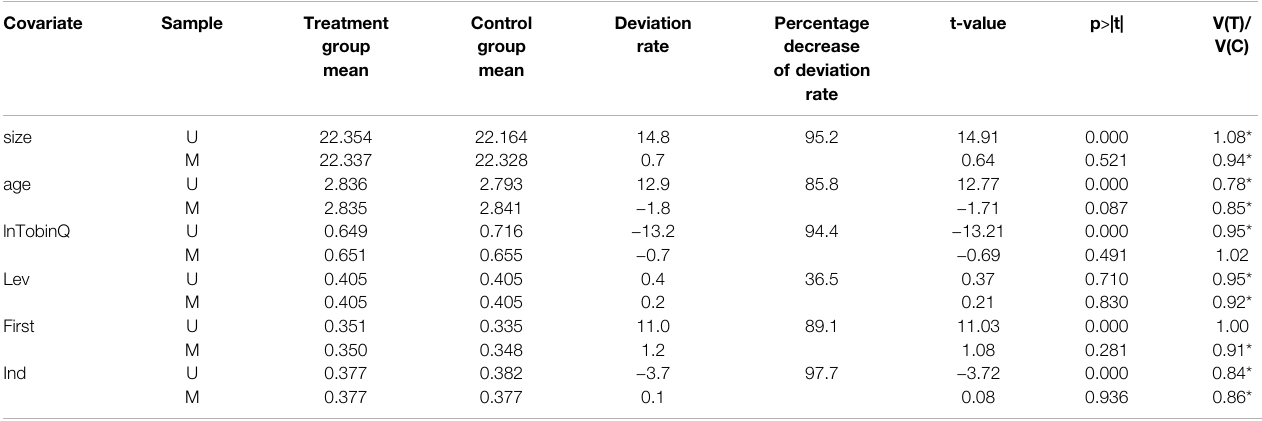
TABLE 5 | Balance test. Covariate Sample